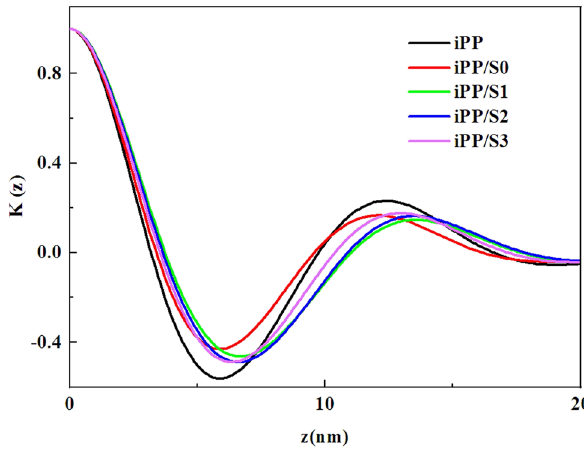
Figure 10: One - dimensional correlation function curves of iPP composites.